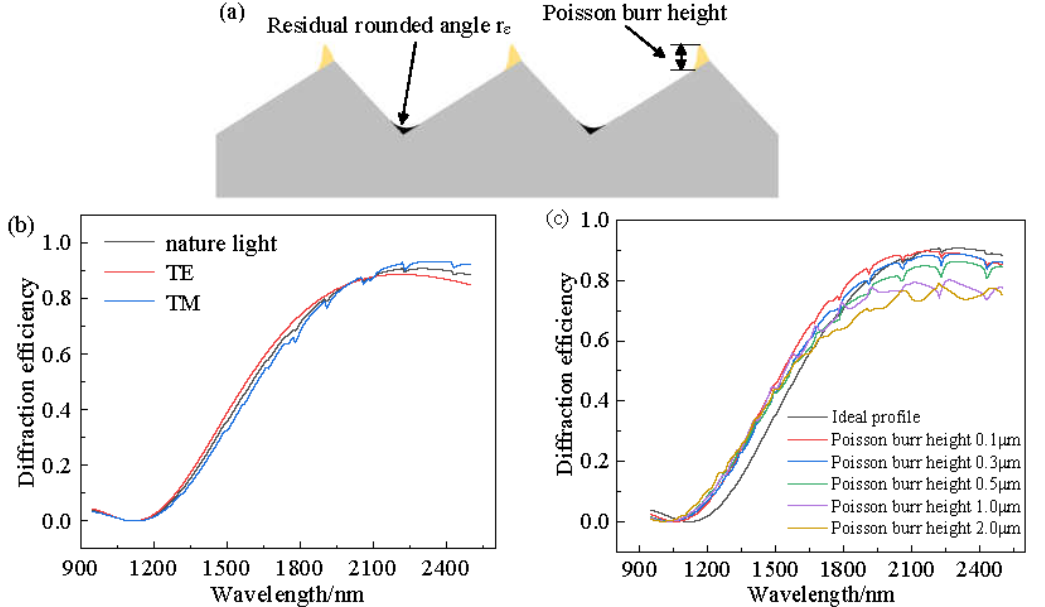
Figure 4. Simulation of the diffraction efficiency of the convex spherical blazed grating. ( a ) Residual rounded angle and Poisson burr. ( b ) Diffraction efficiency of ideal profile grating. ( c ) Grating diffraction efficiency under the influence of different Poisson burr height.